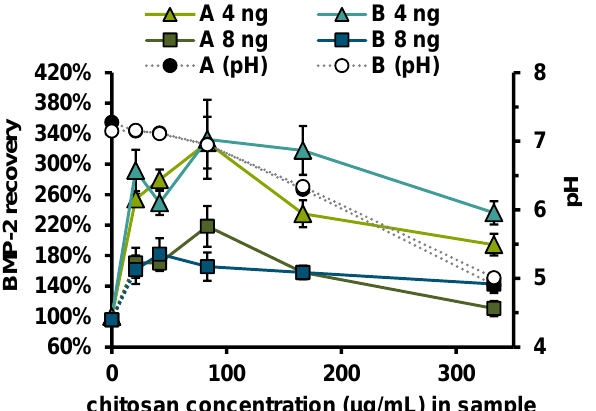
Figure 7. Recovery of 4 ng ( n = 6) or 8 ng ( n = 3) BMP-2 and pH in PTB after addition of different